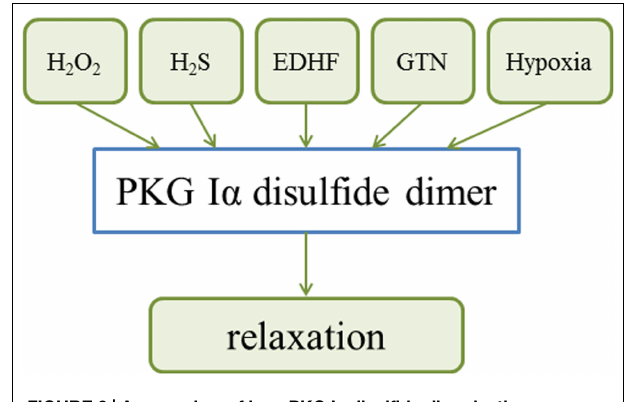
FIGURE 2 | An overview of how PKG I a disulfide dimerisation integrates a variety of stimuli to induce vasodilation and blood pressure